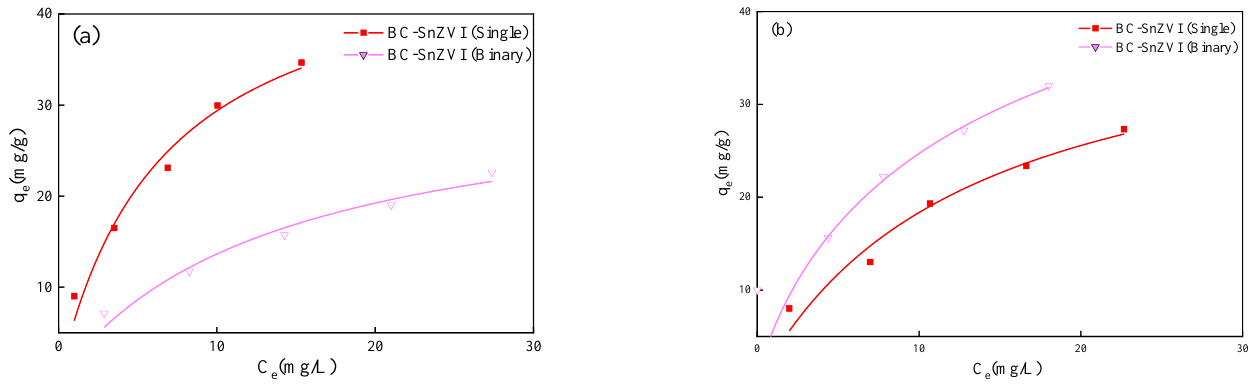
Figure 4. Isothermal adsorption of ( a ) Cd(II) and ( b ) Cr(VI) on BC-SnZVI in single or binary sys- tems.